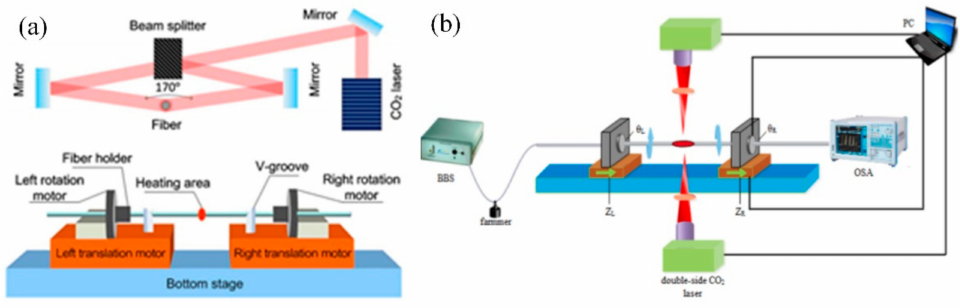
Figure 3. ( a , b ) Schematic diagrams for fabricating HLPFG using double-side CO 2 laser